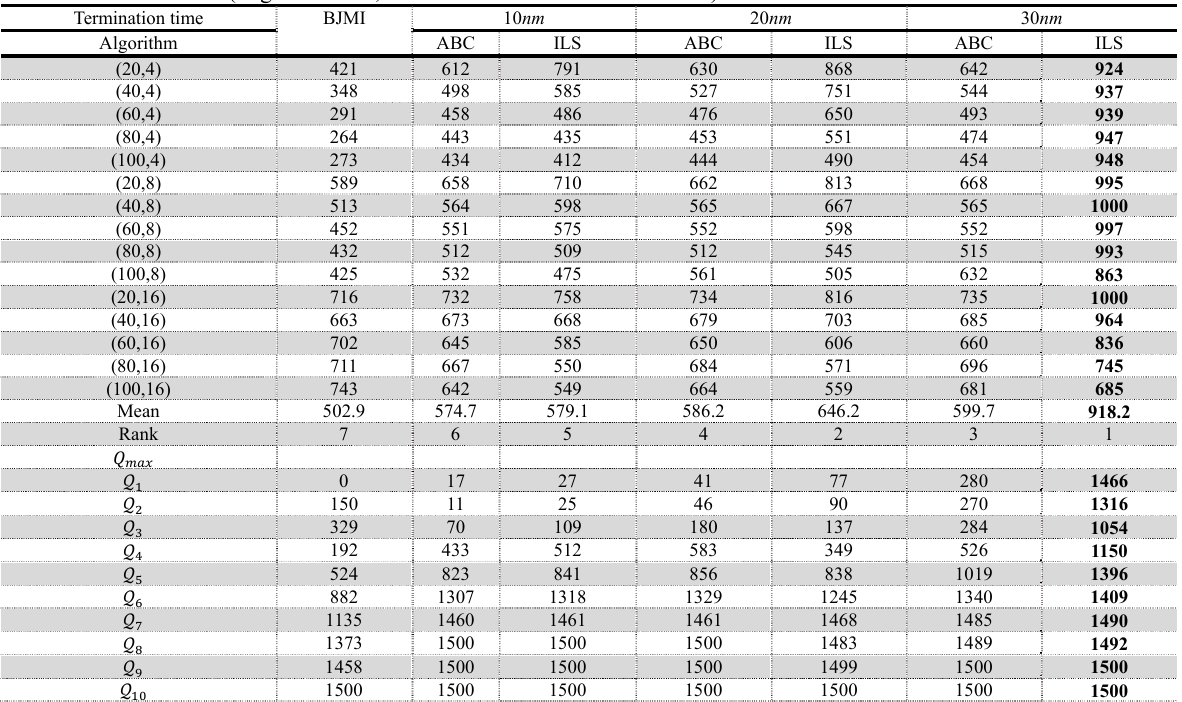
NSR for metaheuristics (large instances, minimum ARPI values are in